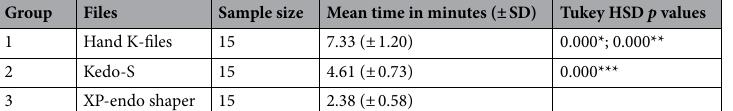
Table 2. Analysis of variations in the time required to complete the procedure using three different file systems. *Comparison between Hand K-files and Kedo-S, **Comparison between Hand K-files and XP-endo Shaper, ***Comparison between Kedo-S and XP-endo Shaper. P value of less than 0.05 was considered as statistically